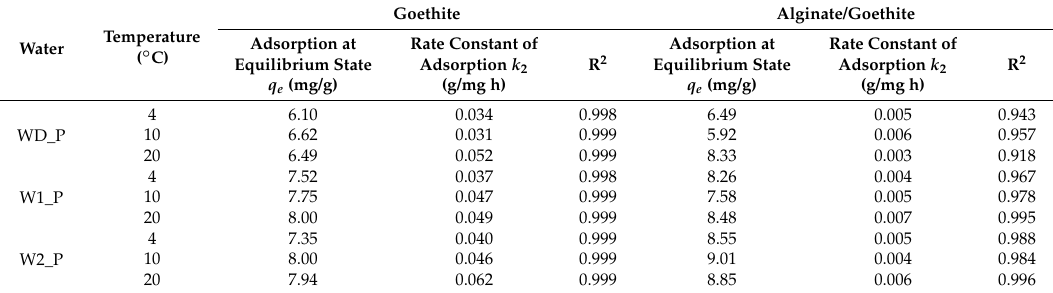
Figure 4. Adsorption kinetics of phosphate ions on goethite and on alginate/goethite composite. ( a ) adsorption on goethite in water WD_P, ( b ) adsorption on alginate/goethite composite in water WD_P, ( c ) adsorption on goethite in water W1_P, ( d ) adsorption on alginate/goethite composite in water W1_P, ( e ) adsorption on goethite in water W2_P, ( f ) adsorption on alginate/goethite composite in water W2_P. Table 2. Estimated pseudo-second-order kinetic model parameters for phosphate adsorption onto goethite and alginate/goethite composite.